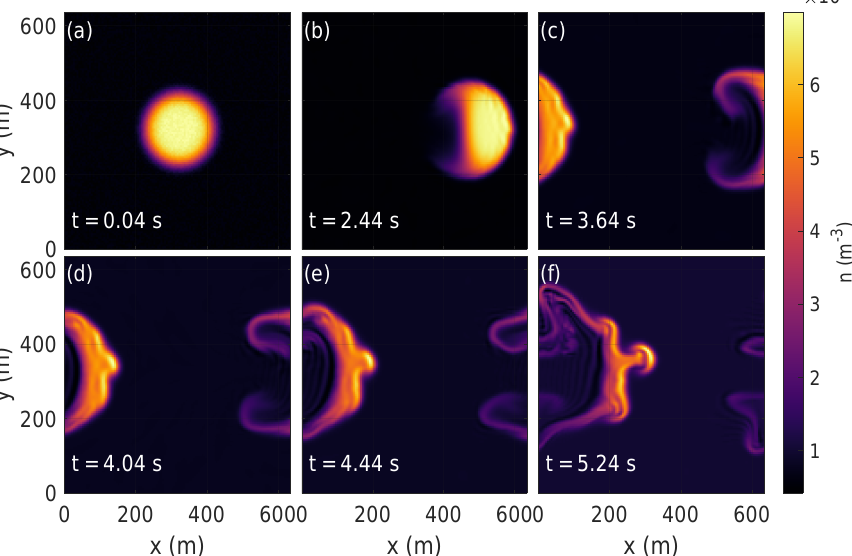
Figure 4. Density color plots of the 2D simulations showing the evolution of a plasma enhancement cloud in an inertial regime. Panel ( a ) shows the initial cloud. In panel ( b ) the cloud begins moving to the right with the trailing edge rolling up. Panels ( c , d ) show the beginning of a GDI developing as the finger-like structure starts forming on the leading edge. Panel ( e ) shows the continued growth of the GDI, as well as the trailing edge vortices continuing to roll up. Panel ( f ) shows the continued vortex mixing, as well as the onset of a secondary